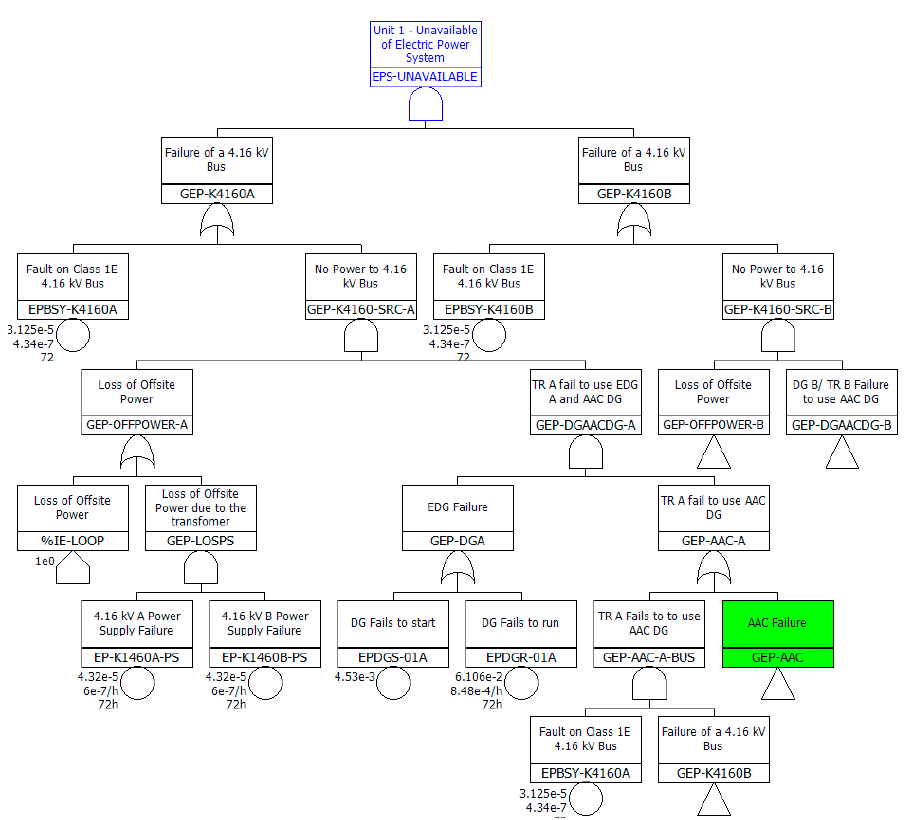
Figure 3. The SFT with the failure of the power supply to Unit 1 in the dual-unit SBO as the top event.